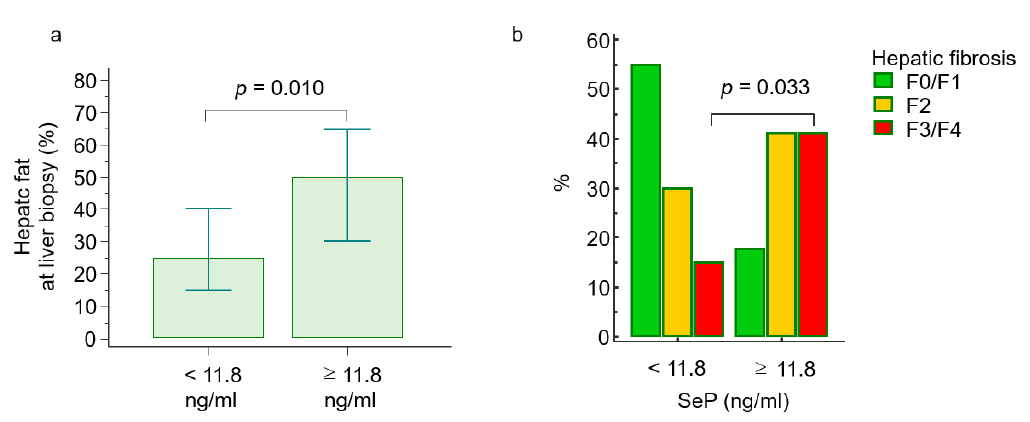
Figure 3. Hepatic steatosis ( a ) and fibrosis ( b ) according to selenoprotein P cut-off. The cut-off value for selenoprotein P corresponds to the 75th percentile (11.8 ng/mL). Abbreviations: fibrosis (F), selenoprotein P (SeP). Table 4. Univariate and multivariable regression for the identification of the metabolic variables associated with the degree of hepatic